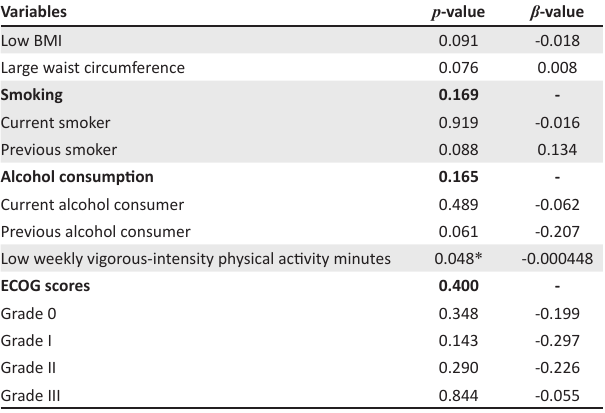
TABLE 6: Factors associated with increased hospital length of stay.